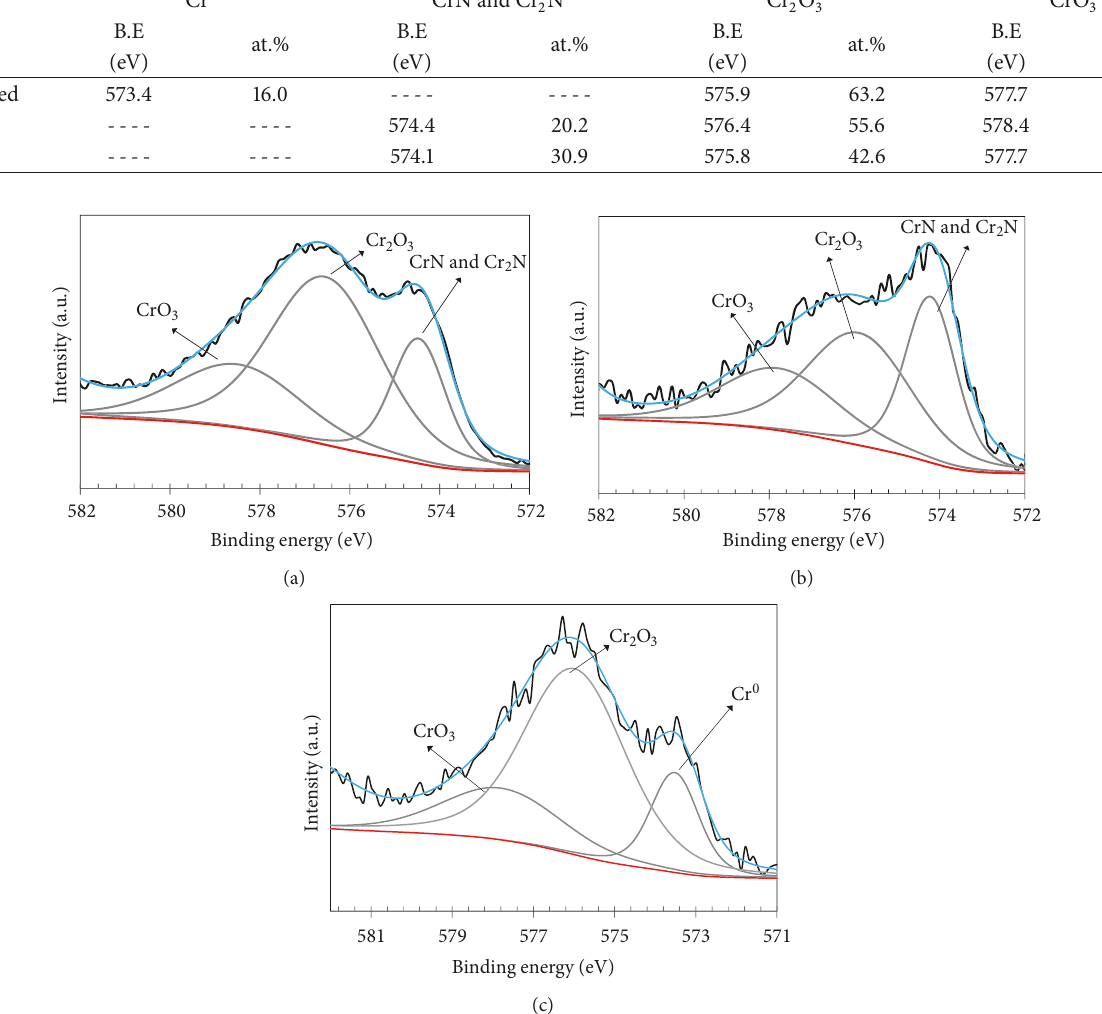
Figure 1: XPS spectra for the Cr2p 3/2 core levels: (a) N; (b) NK and (c) untreated samples.